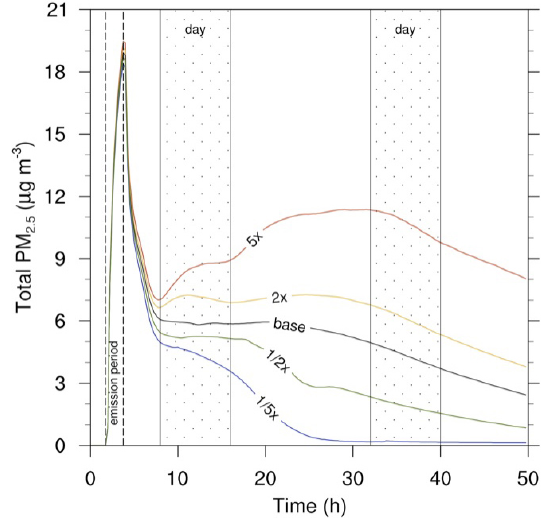
Figure 7. Secondary formation of ammonium nitrate begins at t = 8h and is controlled in magnitude by NH 3 abundance. The delay of ammonium nitrate formation after emissions end is due to the slowness of nocturnal oxidation caused by ozone titration present during the first night. Pictured above is total PM 2 . 5 for the lowest model layer (5m) for each NH 3 sensitivity